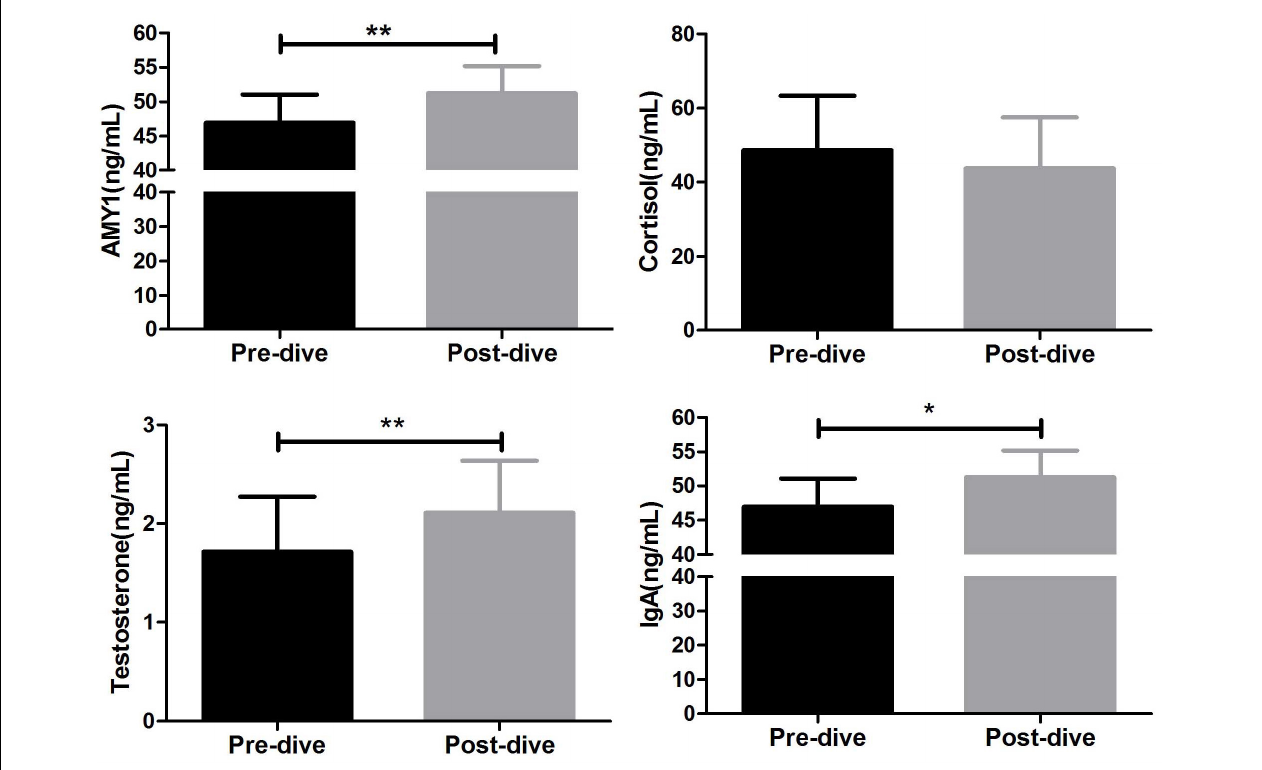
FIGURE 4 | Changes in hormonal indicators between before and after 80 m heliox diving. * P < 0.05, ** P < 0.01 compared with the predive group. Data are expressed as means ± SD ( n = 40). The AMY1 data met the homogeneity of variance and were analyzed using a paired t -test, whereas the cortisol, testosterone, and IgA data did not and were subjected to an unpaired t -test with Welch’s